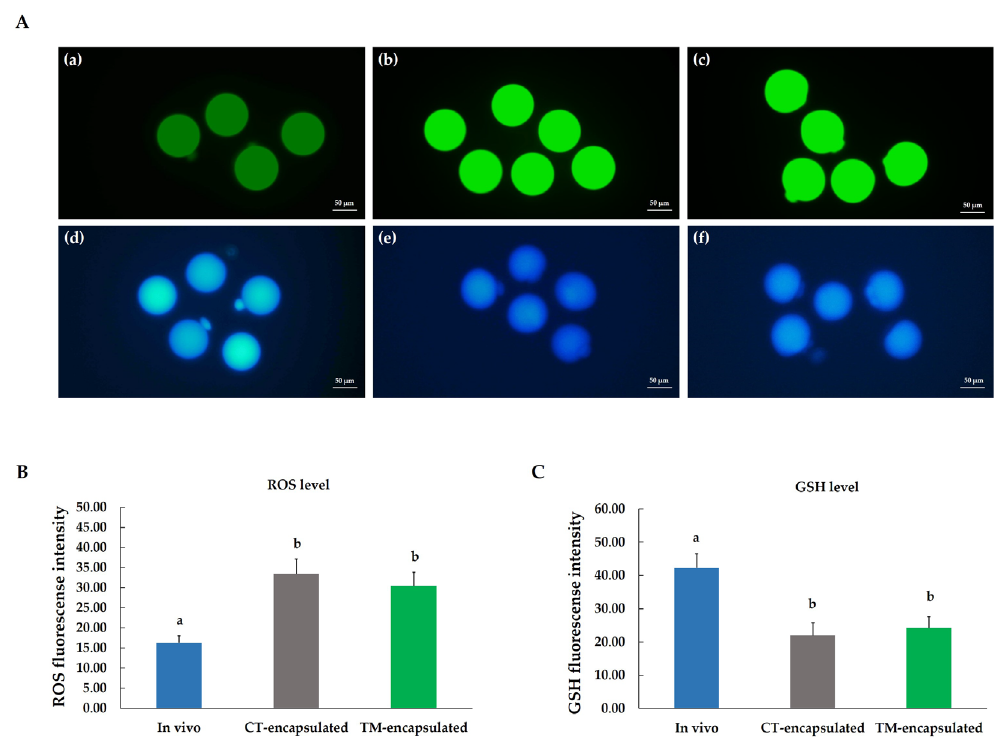
Figure 6. Fluorescent microscope photographs of mature oocytes collected from in vitro follicle cultures. ( A ) Oocytes were stained with H 2 DCFDA (a–c) and CMF 2 HC (d–f) to detect intracellular ROS and GSH levels, respectively. Mature oocytes retrieved from in vivo (a,d), CT-encapsulated (b,e), and TM-encapsulated (c,f) follicles. ( B ) Fluorescence intensity of intracellular ROS level. ( C ) Fluo- rescence intensity of intracellular GSH level. Scale bar: 50 µm. Different letters (a,b) indicate the significant differences at p < 0.05 in mature oocytes derived from in vivo and in vitro. Comparison between groups was performed using ANOVA followed by Duncan’s new multiple range test. n = 3 measurements in each group.